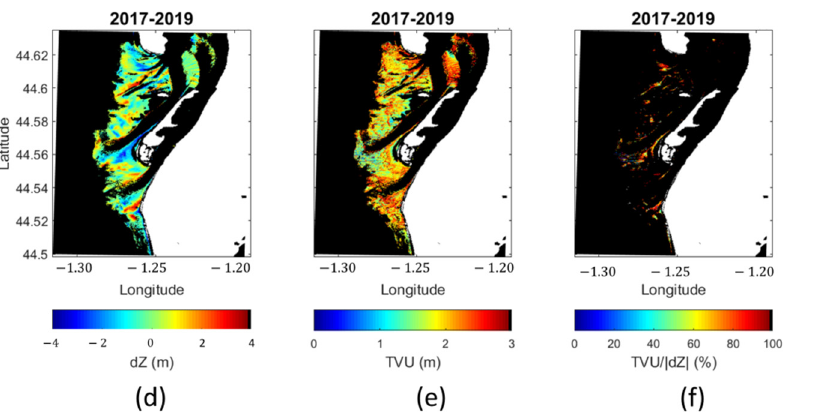
Figure 12. Maps of the 3-meter and 4-meter isobaths in ( a ) 2017 and ( b ) 2019. ( c ) comparison of the position of the 4-meter isobaths of 2017 and 2019. ( d ) Maps of the bathymetric vertical changes ( dZ ) between 2017 and 2019, ( e ) total vertical uncertainty ( TVU ), and ( f ) TVU to dZ absolute value ratio expressed in